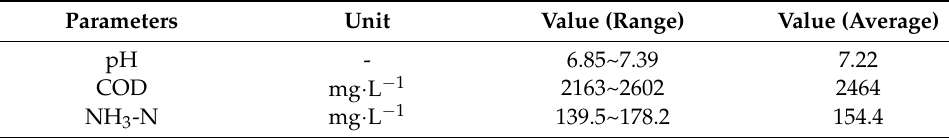
Table 1. Character of landfill leachate